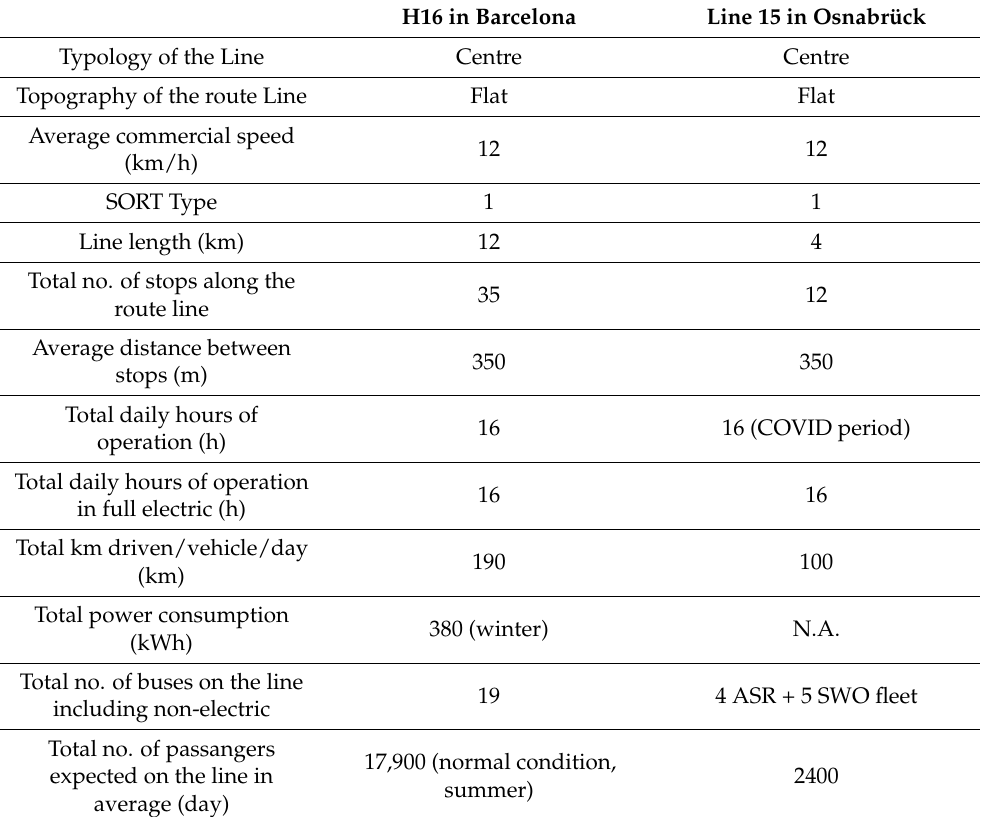
Table 4. Characteristics of route Line’s demos in Barcelona and